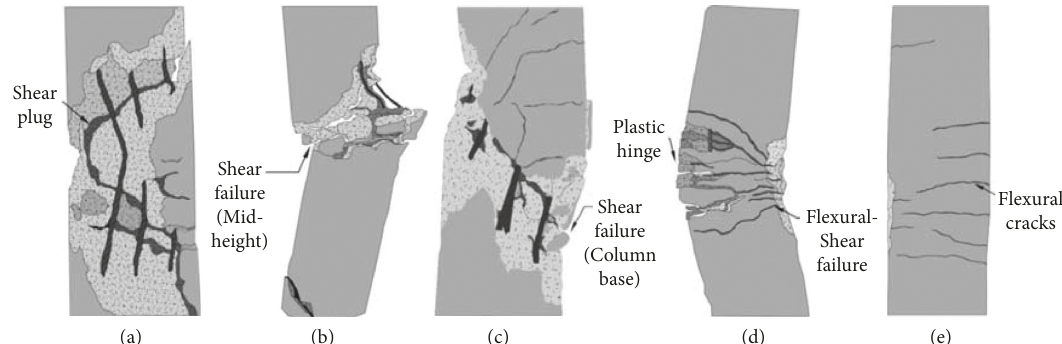
Figure 9: Typical failure modes of RC bridge column under impact load [6]: (a) punching shear; (b) shear hinge; (c) diagonal shear failure; (d) combined flexural-shear failure; (e) flexural failure.